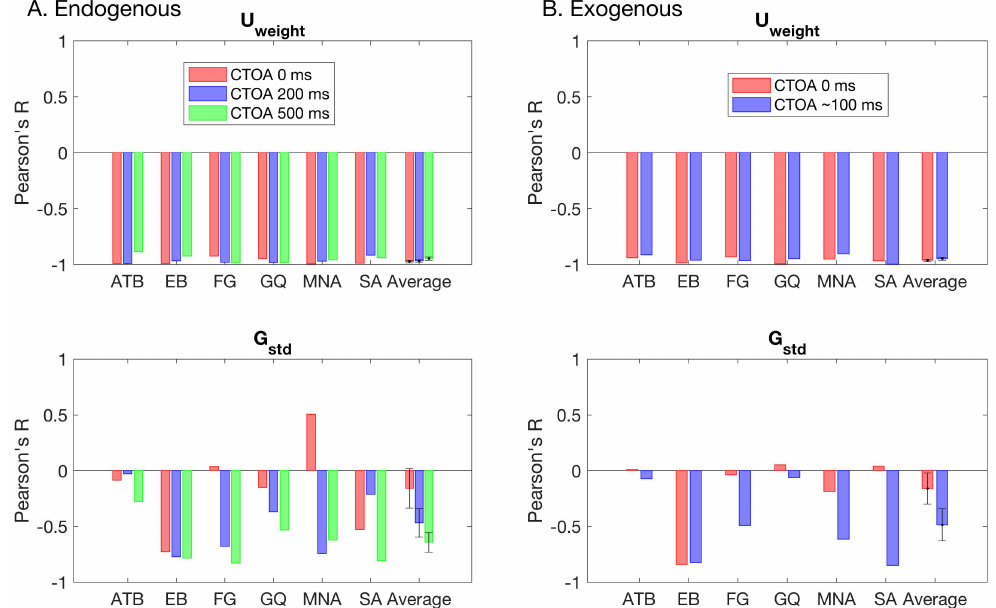
Figure 7. The correlations between masking functions and the GU model parameters for the ( A ) endogenous, and ( B ) exogenous attention conditions. The top row represents the standard deviation of the Gaussian whereas the bottom row represents the weight of the